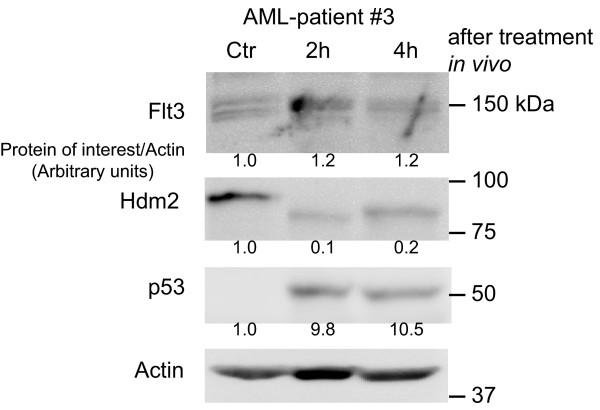
Induction therapy of AML reciprocally regulates Flt3 and Hdm2 proteins in vivo. AML cells sampled from a patient undergoing induction chemotherapy with an anthracycline and cytarabin were subjected to Western blotting and analyzed for Flt3, Hdm2 and p53 expression. The mean intensity on one representative Western blot was calculated and normalized to Actin. The numbers shown are in arbitrary units.